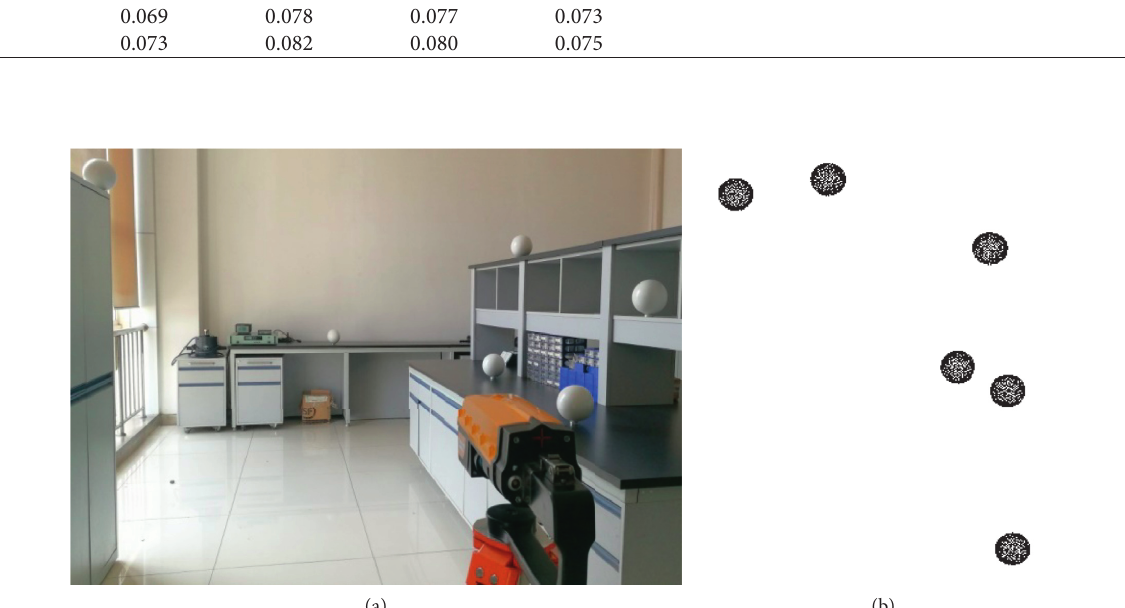
Figure 6: Scanning the test target sphere using the 3D laser scanner.